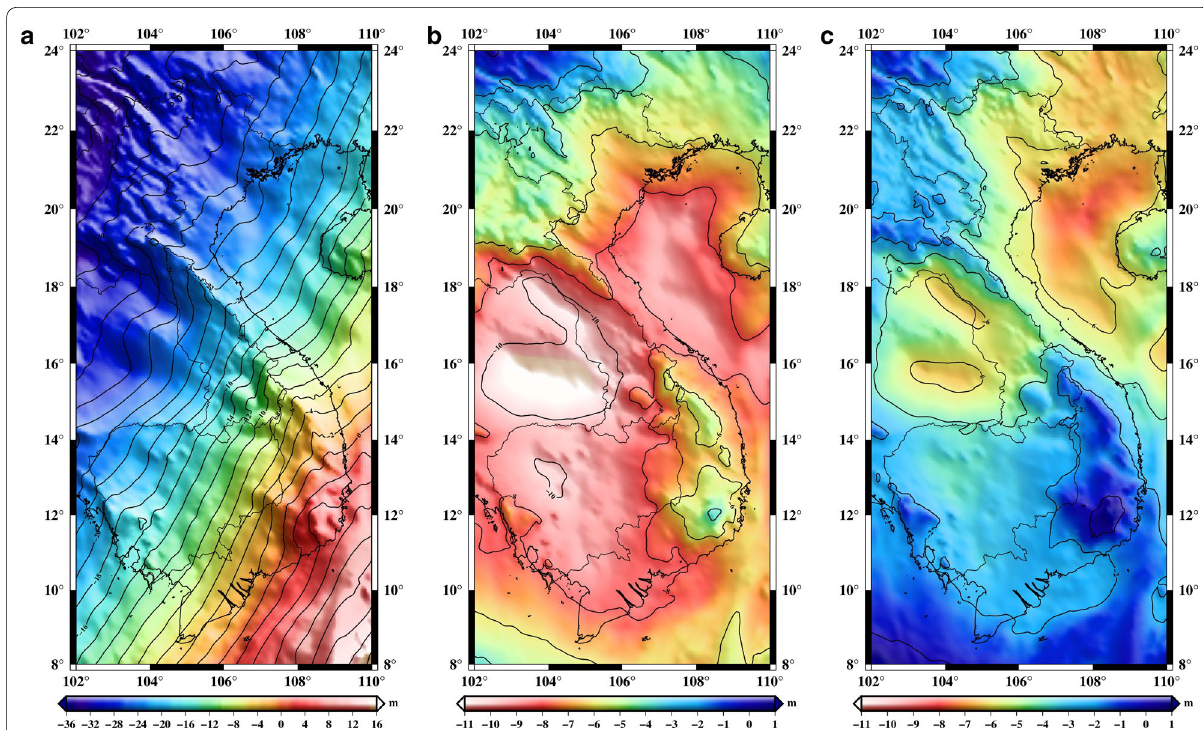
Fig. 4 a Geoid undulations by adding transformation from gravimetric quasigeoid to geoid, b residual geoid undulation by simple subtraction of low d/o from 2 to 9, and c residual geoid undulation by removing low d/o from 2 to 9 with a 1D-Gaussian